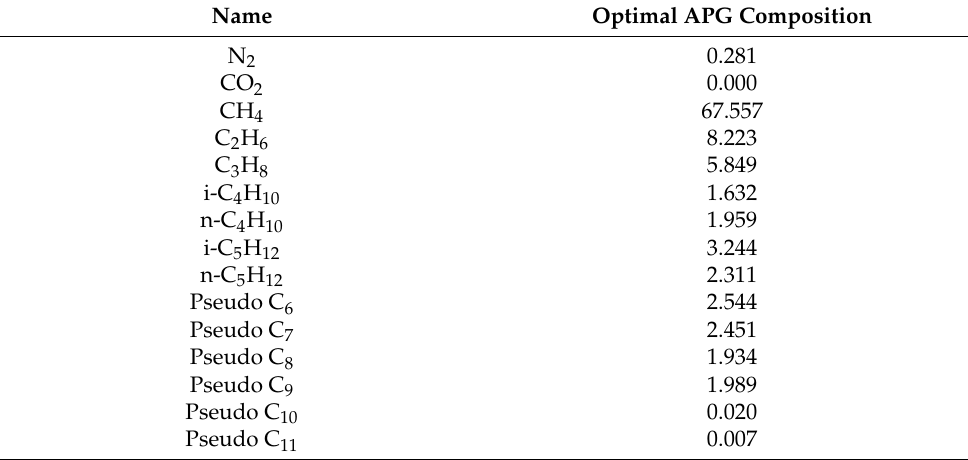
Table 1. Optimal composition of the working agent (APG) for a gas-lift well of the Dragon